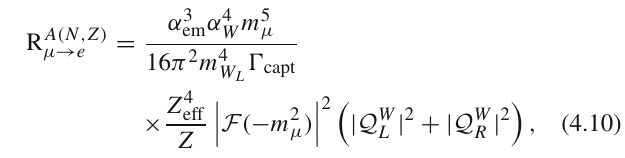
Fig. 4 Branching ratio of the process μ → 3 e as a function of lightest neutrino mass, m 1 ( m 3 ) for NH (IH) pattern Similarly, the bound on light neutrino mass from μ → e conversion rate with the mediation of heavy neutrino N and sterile neutrino S can be found as